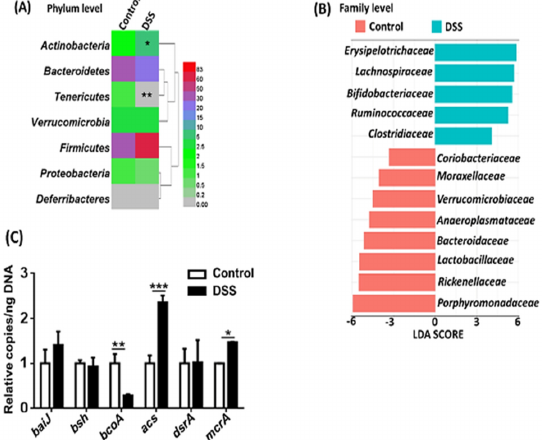
Figure 4. Alteration of gut microbiota composition in DSS-induced colitis mice. ( A ) Change in bacteria abundance at the phylum level. Data are expressed as mean ± SD. n = 9 per group. Mann- Whitney U test, * p < 0.05, ** p < 0.01. ( B ) Difference in family level identified by LEfSe (LDA > 2, p < 0.05). ( C ) Quantification of bacteria genes that have known functions. Copy number per ng DNA